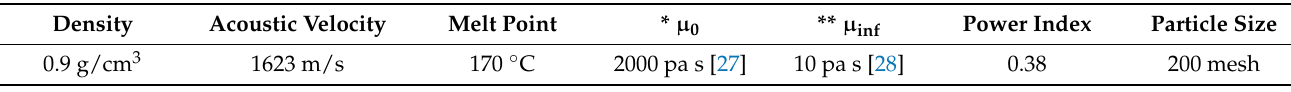
Table 1. Material properties of polypropylene.